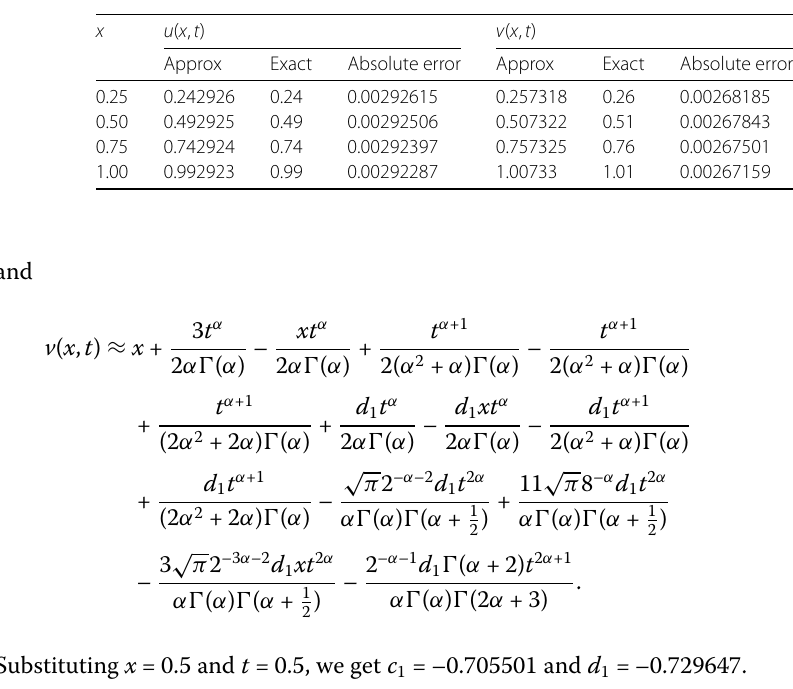
Table 5 Exact and approximate result of Test example